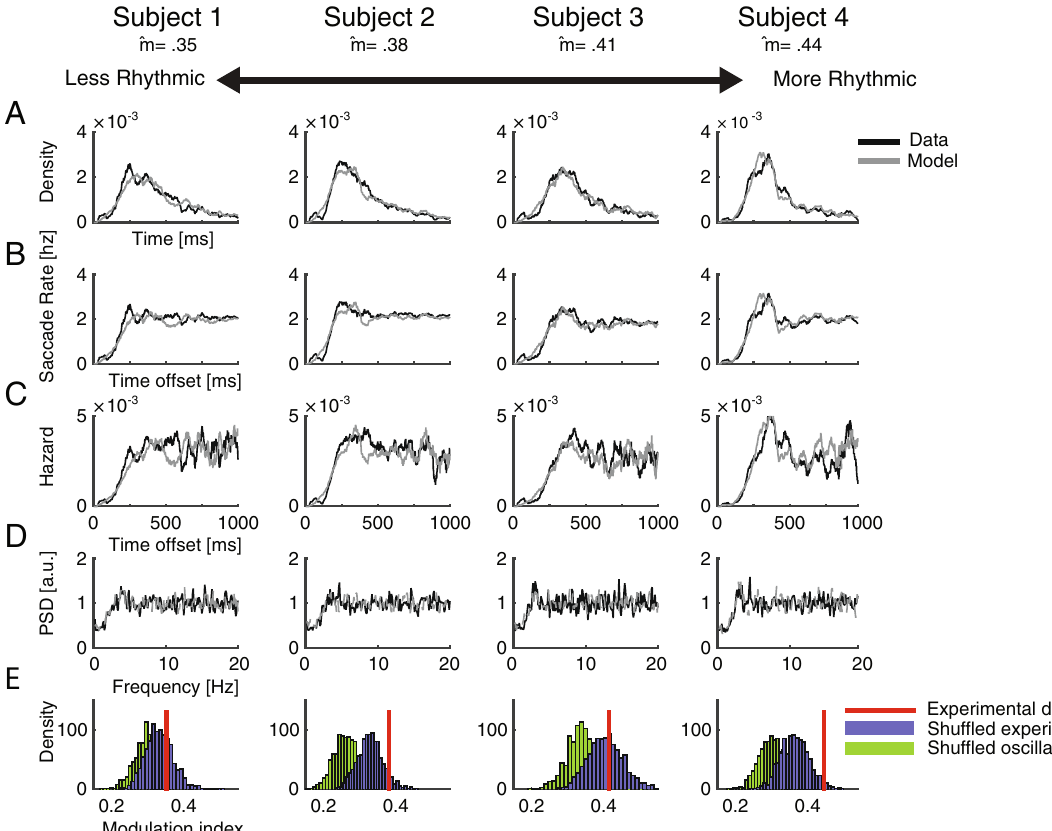
Figure 2. Statistical properties of single-subject saccade sequences during free-view (Exp 1). ( A–E ) Subjects ordered from left to right according to their level of rhythmicity as indicated by their modulation index. ( A ) Inter-saccade intervals distributions of 4 subjects (black) and their fitted first-order model (gray). ( B ) Autocorrelation functions of saccade events normalized to represent post-saccadic saccade rate. ( C ) Hazard Functions. ( D ) Power spectra of saccade sequences. ( E ) Histograms of modulation indices calculated on 1000 shuffles of intervals of either real data (blue) or simulated oscillatory data (green). The red bar indicates the original modulation